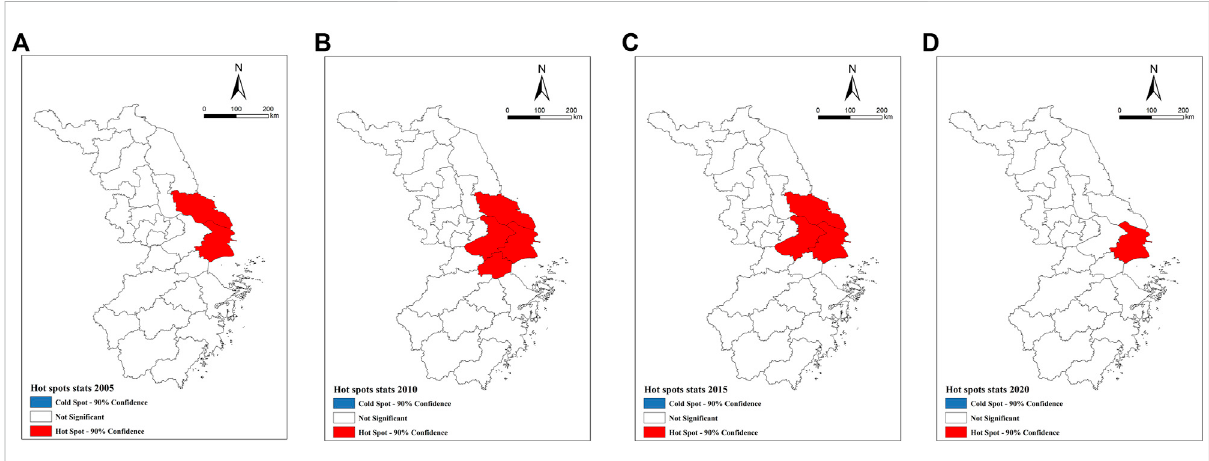
FIGURE 2 Distribution of CHP technology innovation hotspots in the Yangtze River Delta in 2005 (A) , 2010 (B) , 2015 (C) and 2020 (D)